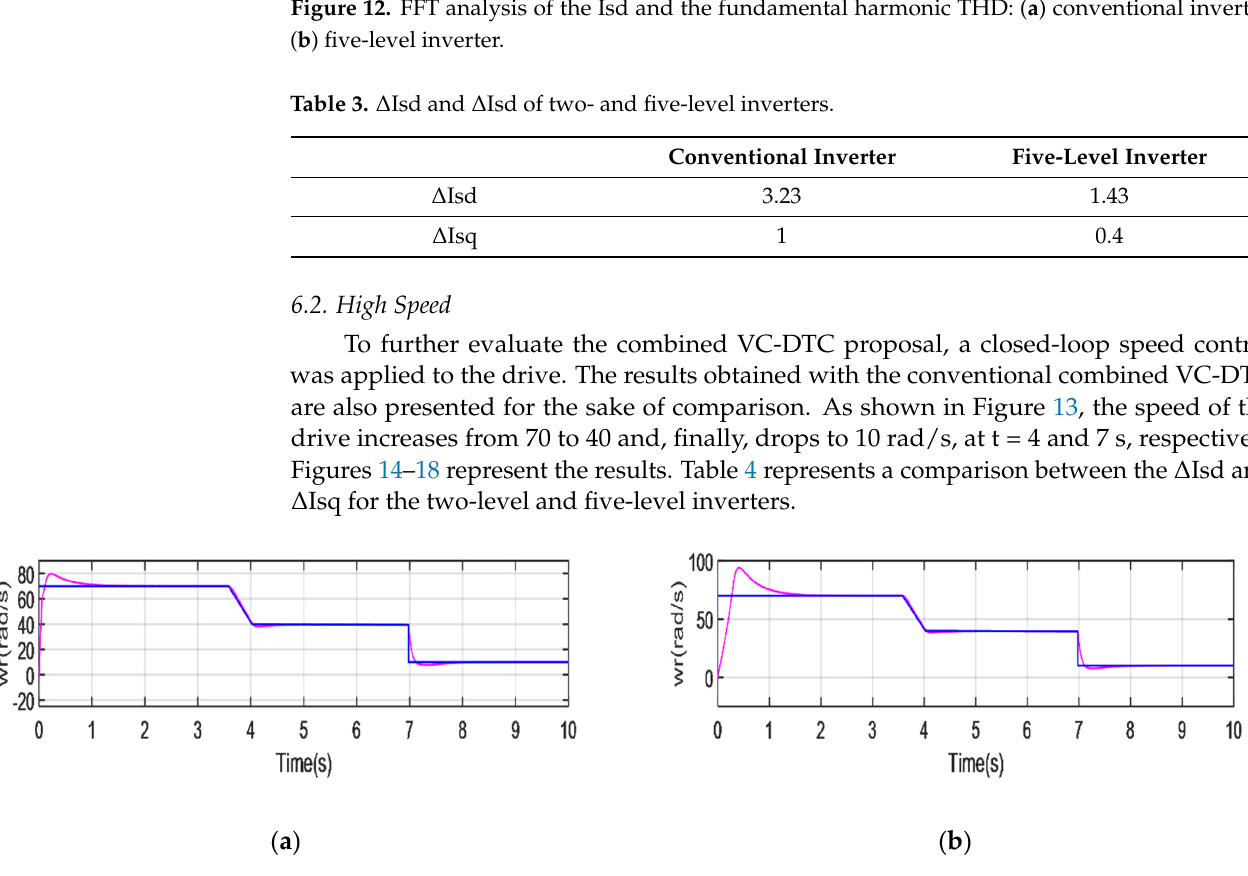
Figure 13. Speed response: ( a ) conventional inverter; ( b ) five-level inverter.